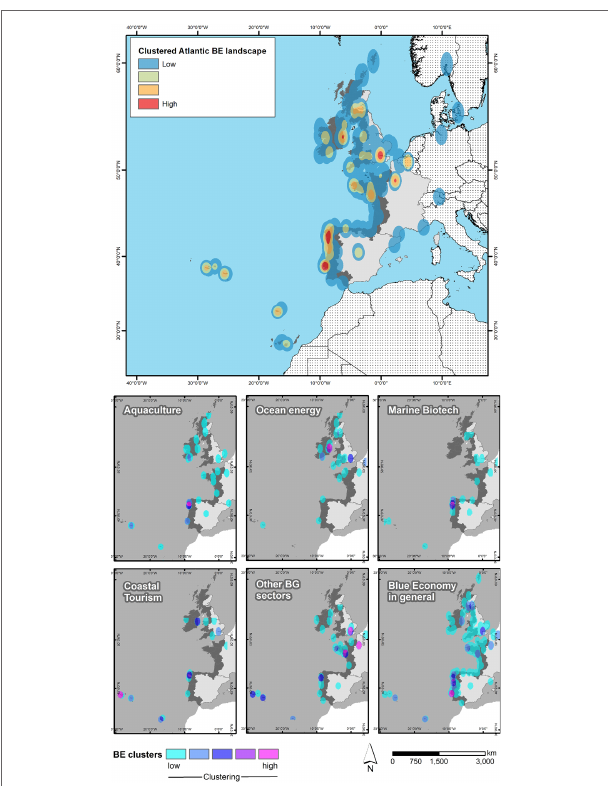
FIGURE 4 | Overall clusters of the Atlantic Blue Economy landscape. Spatially clustered distribution of Blue Economy stakeholders by sector in the NEAA.